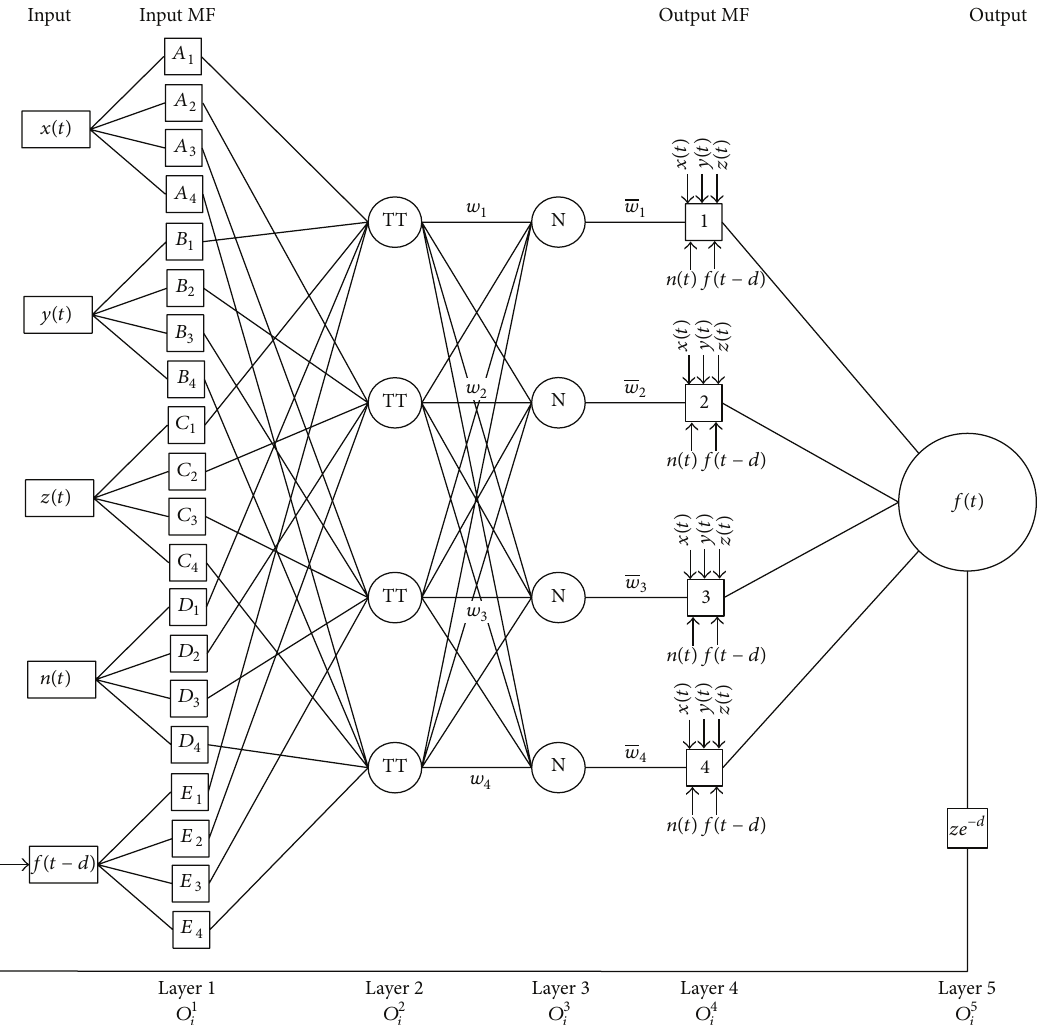
Figure 4: OF neurofuzzy architecture showing four input and one output